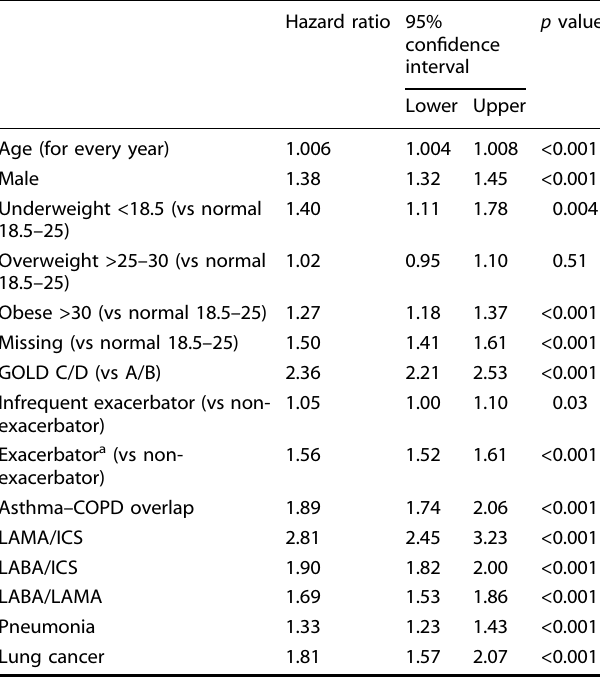
Table 4. Predictive value of the different characteristics of patients newly diagnosed with COPD for time to initiation of